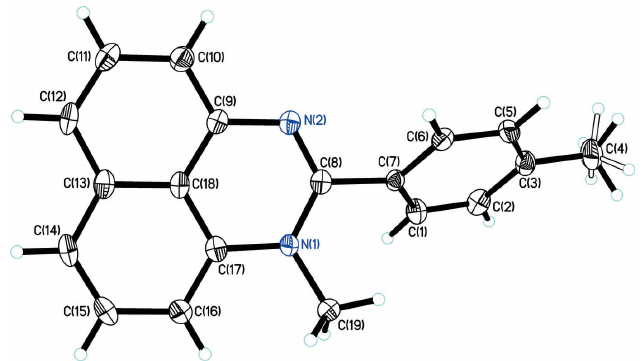
Figure 3 Hydrogen bonding and (cid:2) — (cid:2) stacking interactions in the crystal structure of 1- H -2-( p -tolyl)-perimidine ( 1 ), with displacement ellipsoids drawn at the 50% probability level. Hydrogen atoms of the minor disorder component are omitted for clarity.